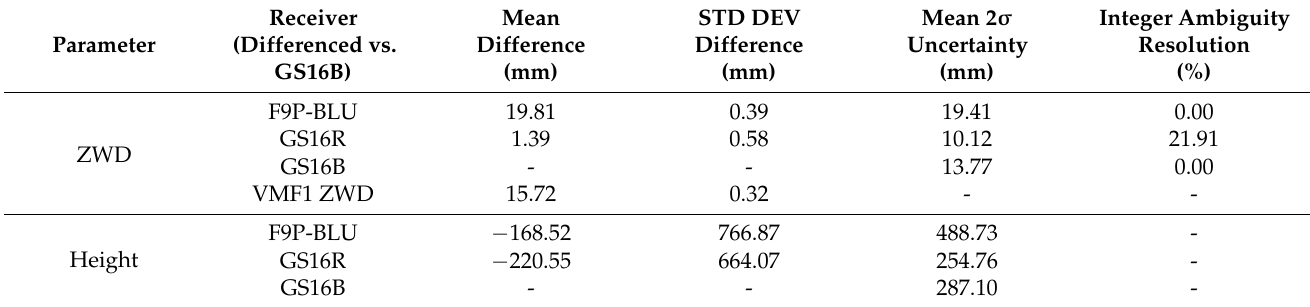
Figure 22. Dataset C ZWD profiles for full trajectory. Local time is UTC − 6:00. Table 6. Dataset C ZWD and profile mean differences, standard deviations, average 2 σ uncertainties, and integer ambiguity resolution success rates for full